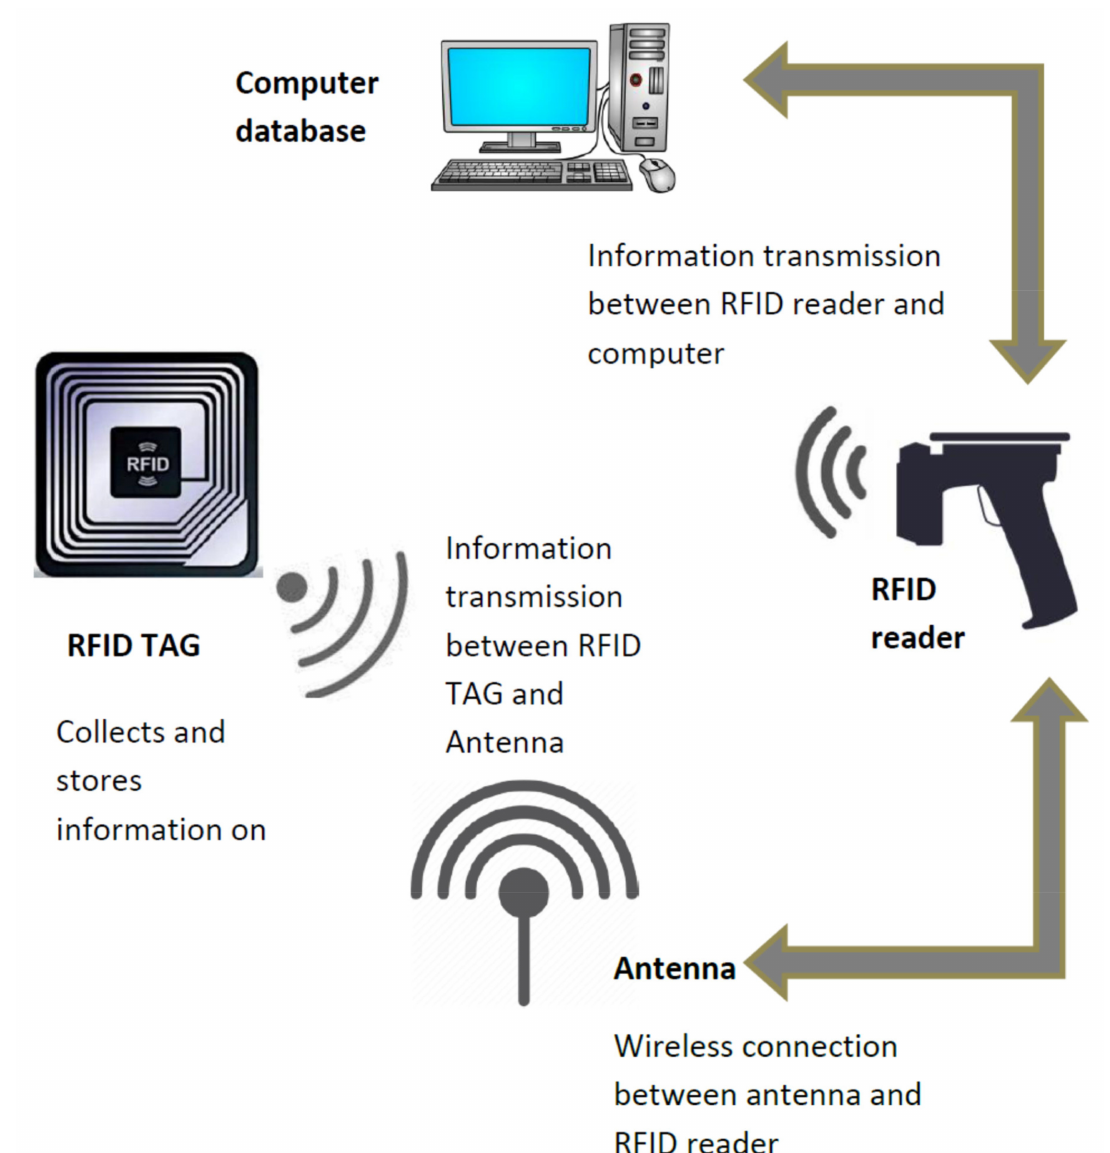
Figure 2. Basic radio frequency identification (RFID) system. Source: own